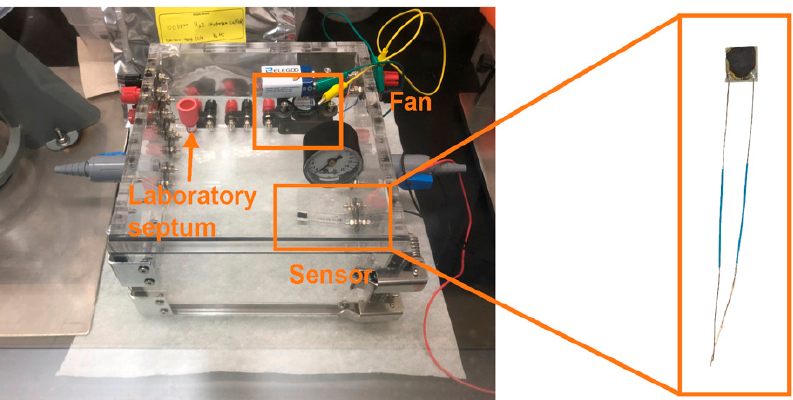
Figure 2. An experimental setup and an RGO-based sensor are shown.